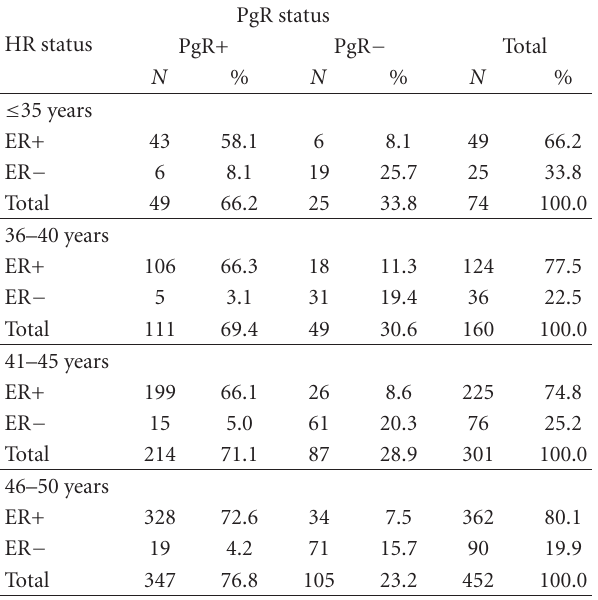
Table 5: Hormone receptor status stratified by age group. Younger age more frequently correlates with lack of hormone receptors.